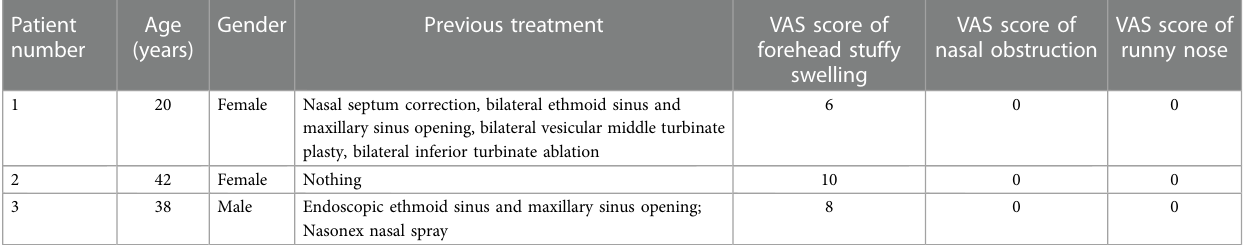
TABLE 1 Patients ’ clinical